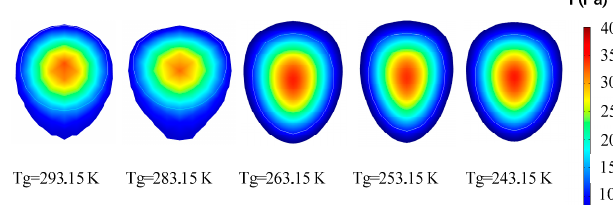
Figure 8. Pressure distribution cloud of the free-falling water droplet at t = 0.06 s. The white circle is the interface of water droplet and air.